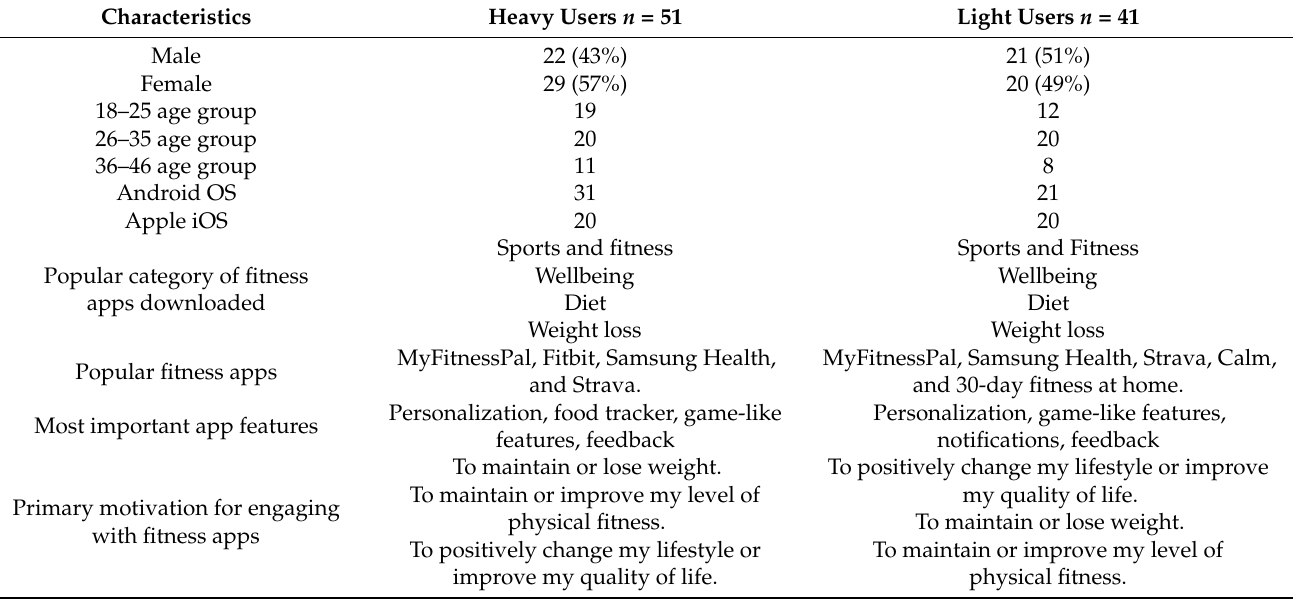
Table 5. Comparison between heavy and light